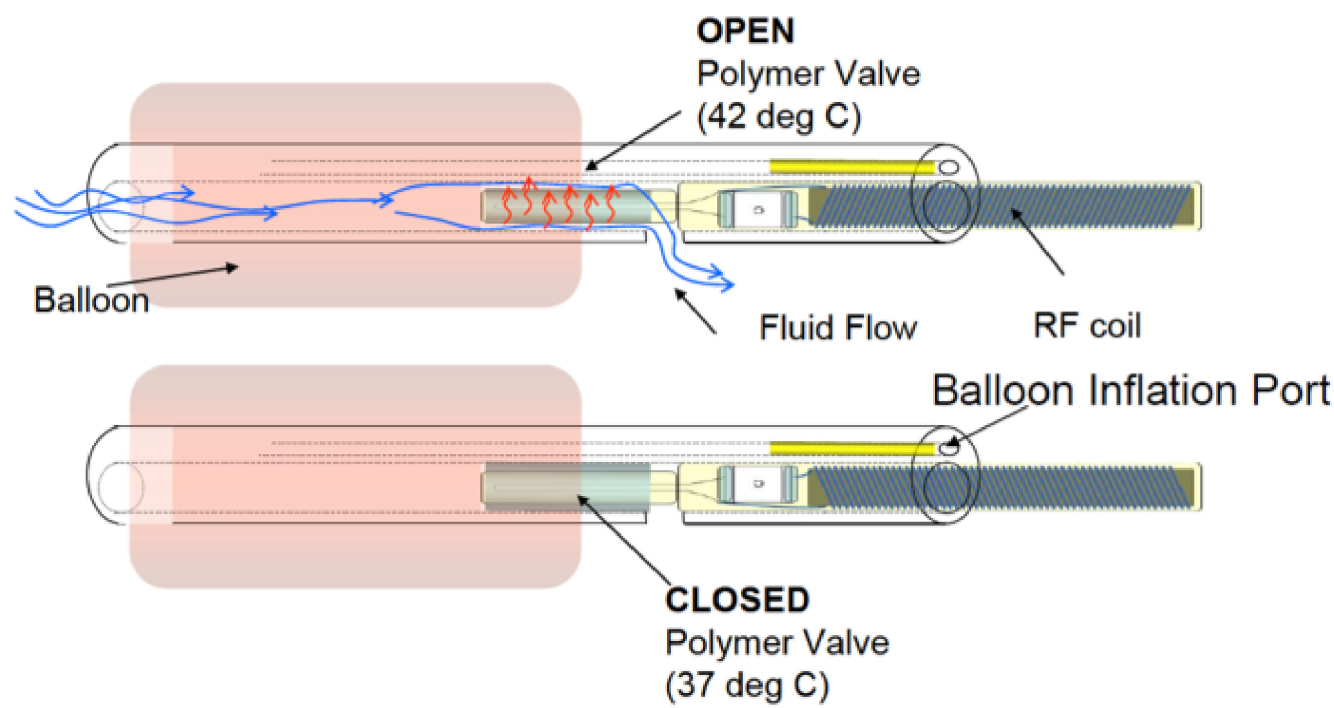
Fig 1. Schematic representation of the dynamic tracheal occlusion valve. It comprises a saline filled detachable balloon that obstructs the fetal trachea and provides an internal flow path via an RF actuatable thermo-responsive polymer-valve.